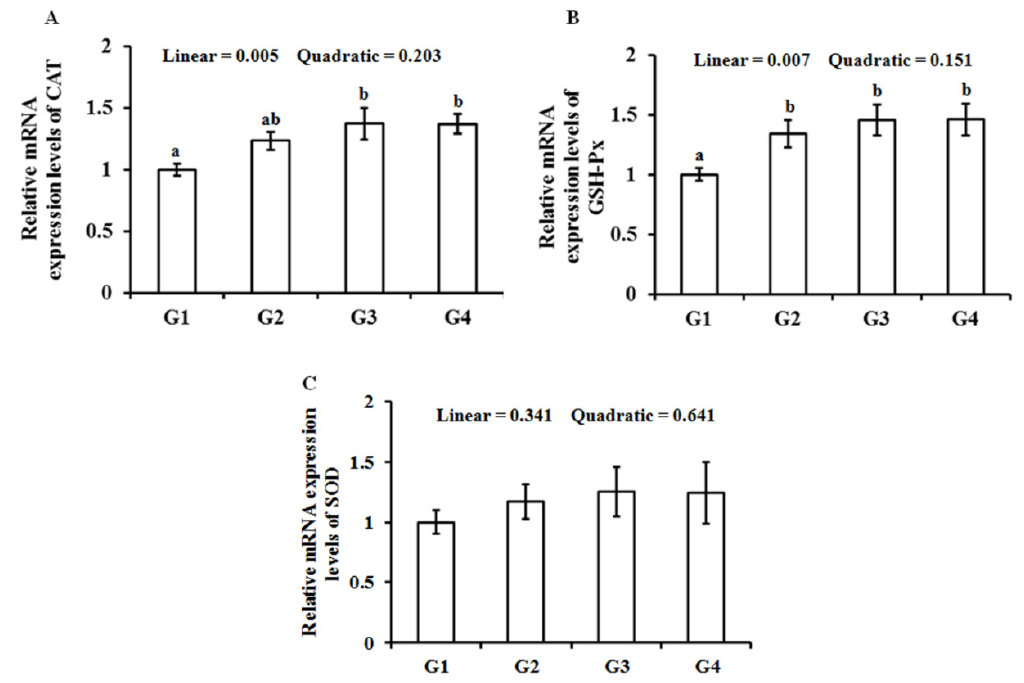
Figure 2. Effect of Gln on CAT ( A ), GSH-Px ( B ), and SOD ( C ) gene expression of the breast muscle in heat-stressed broilers. a, b: Values in columns with different letters differ significantly ( p < 0.05). Broilers in the G1, G2, G3, and G4 groups were housed in the hot environment and fed the basal diet with 0%, 0.5%, 1.0%, and 1.5% Gln, respectively.